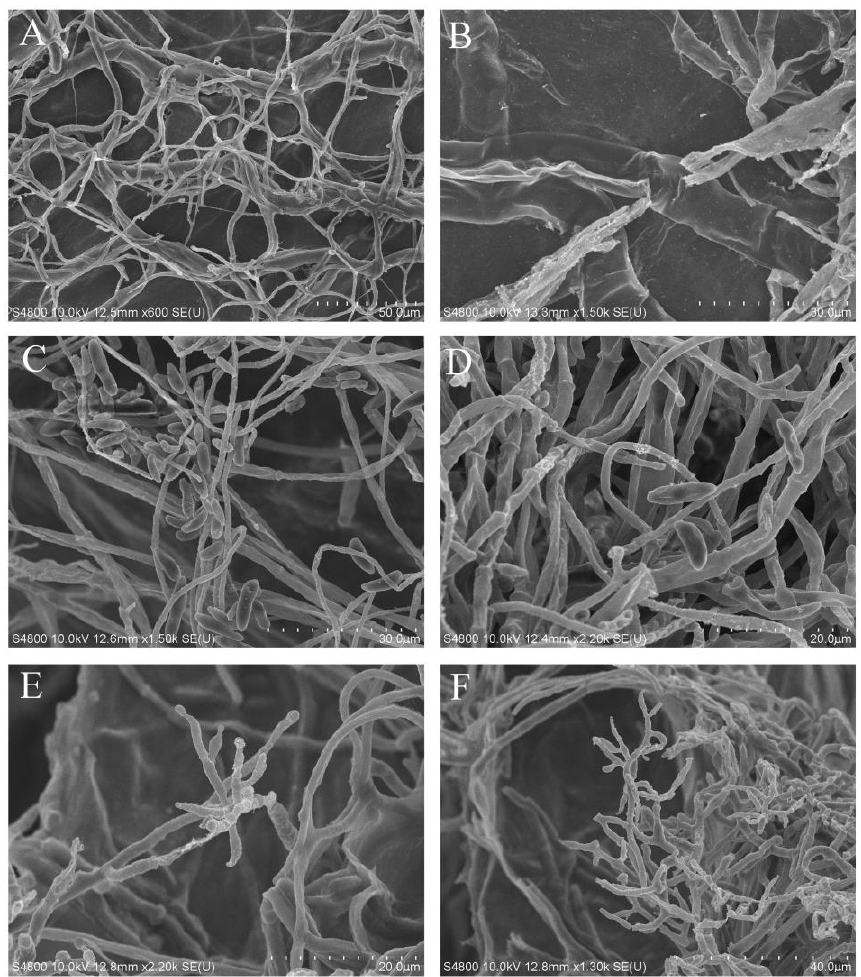
Figure 6. T. longibrachiatum HL167 and F. oxysporum morphology by SEM. ( A , C , E ) Morphological characterization of T. longibrachiatum HL167 and F. oxysporum in PDA without 200 mM NaCl. ( A ) T. longibrachiatum HL167 and F. oxysporum in dual culture. ( C ) F. oxysporum , E, T. longibrachiatum HL167. ( B , D , F ) Morphological characterization of T. longibrachiatum and F. oxysporum in PDA with 200 mM NaCl. ( B ) T. longibrachiatum HL167 and F. oxysporum in dual culture. ( D ) F. oxysporum , ( F ) T. longibrachiatum HL167.